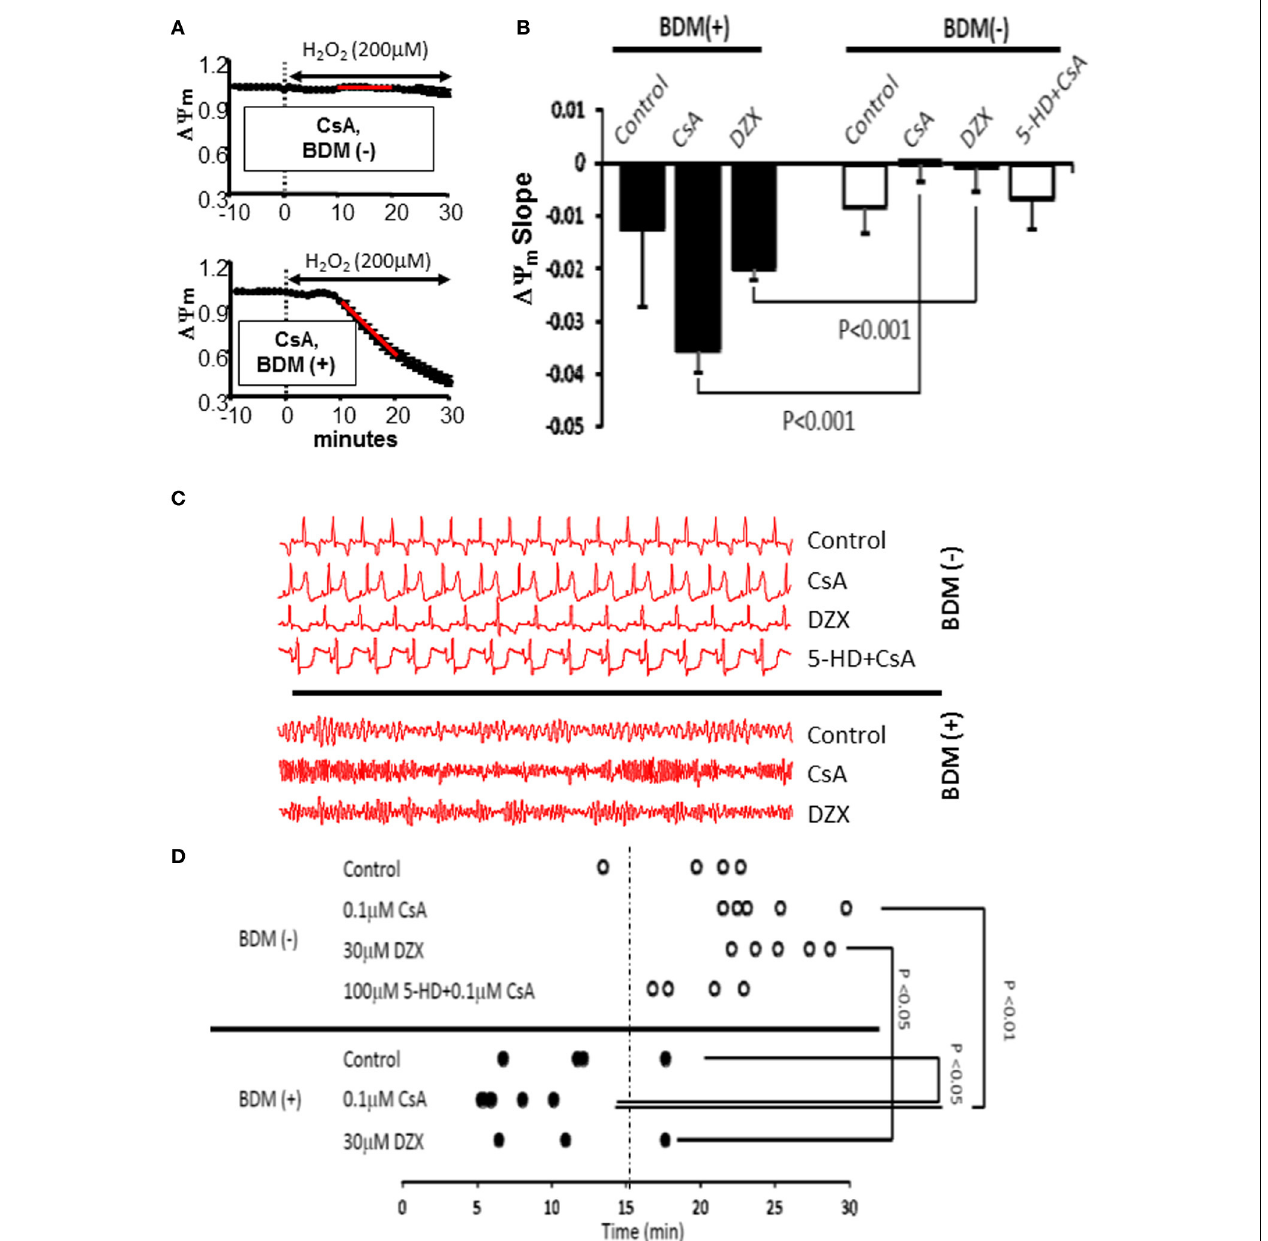
FIGURE 6 | Cross-talk between mK ATP and mPTP modulates mitochondrial and electrical response of hearts to OS. (A) (cid:2)(cid:3) m response to OS in CsA-treated hearts without (top) and with (bottom) concomitant perfusion with the chemical phosphatase BDM. The relative sensitivity of hearts to OS-induced mitochondrial dysfunction was quantified by measuring